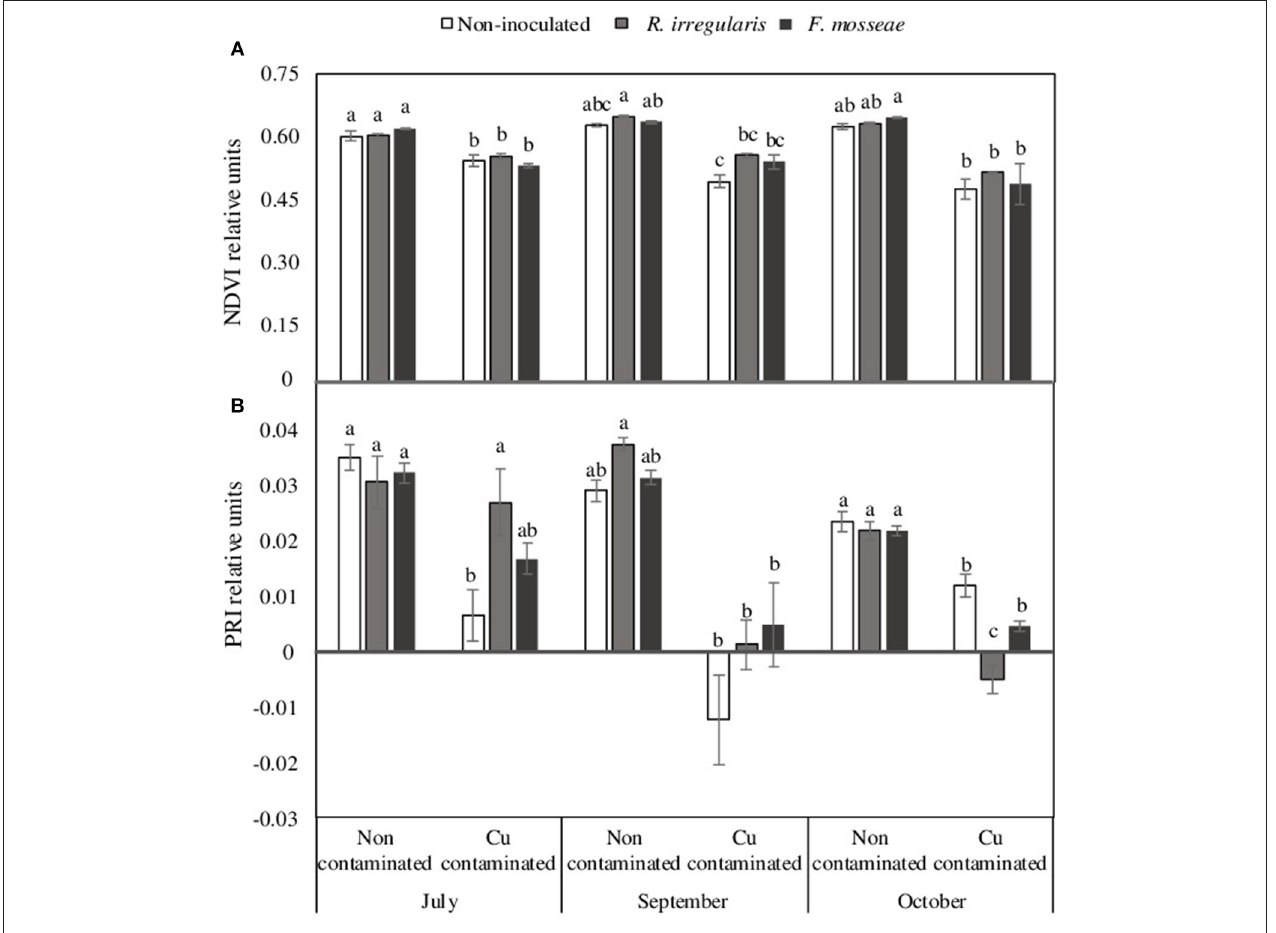
FIGURE 2 | (A) Normalized difference vegetation index, NDVI and (B) Photochemical reflectance index, PRI, data of Touriga Nacional grapevine variety plants grafted onto 1103 Paulsen rootstock growing in Cu-contaminated or non-contaminated soil at different time points during the growing season. Bars indicate the average of five plants per treatment ± standard error. Different letters indicate significant differences at each month (July, September or October) according to Tukey b or Dunn-Bonferroni tests at p ≤